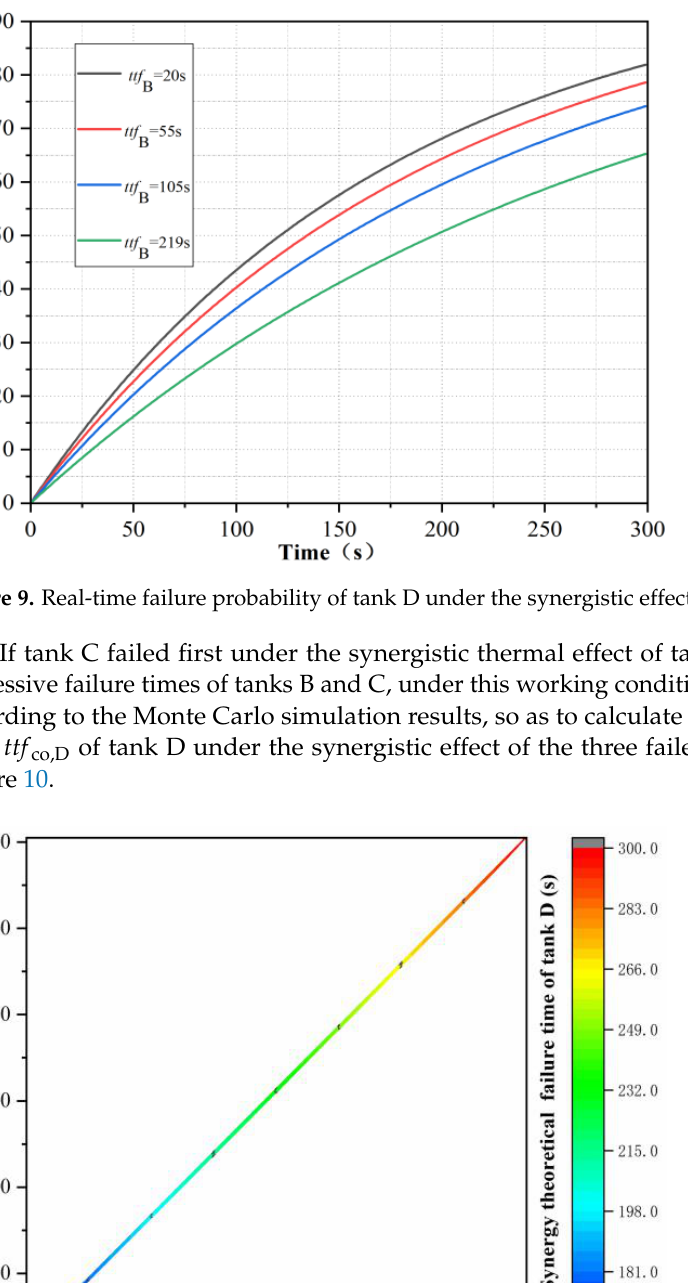
Table 3. Theoretical failure time of tank B, C, D under synergy effect. Failure Time of Tank B (s)